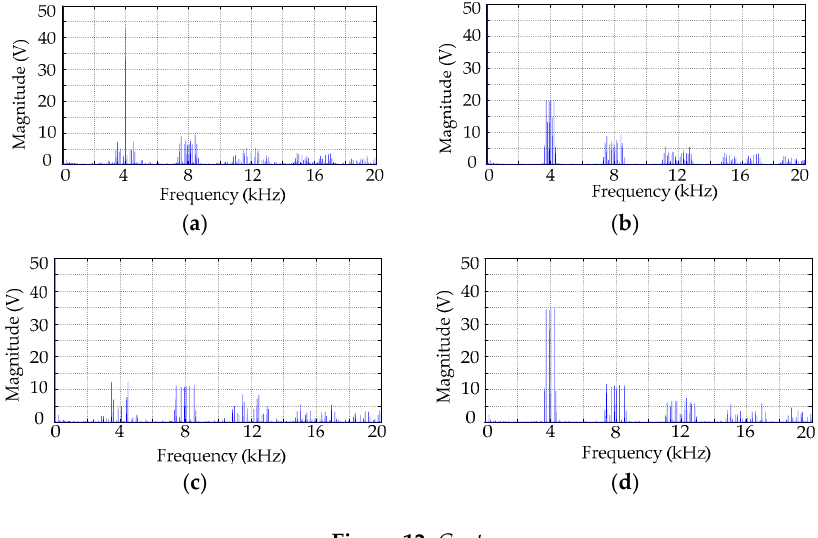
Figure 11. Experimental waveforms of DCPDPWM method and PSCPWM method with circulating current harmonics cancellation scheme: ( a ) phase voltage and circulating current of DCPDPWM; ( b ) phase voltage and circulating current of PSCPWM; ( c ) line-to-line voltage and phase current of DCPDPWM; and ( d ) line-to-line voltage and phase current of PSCPWM.